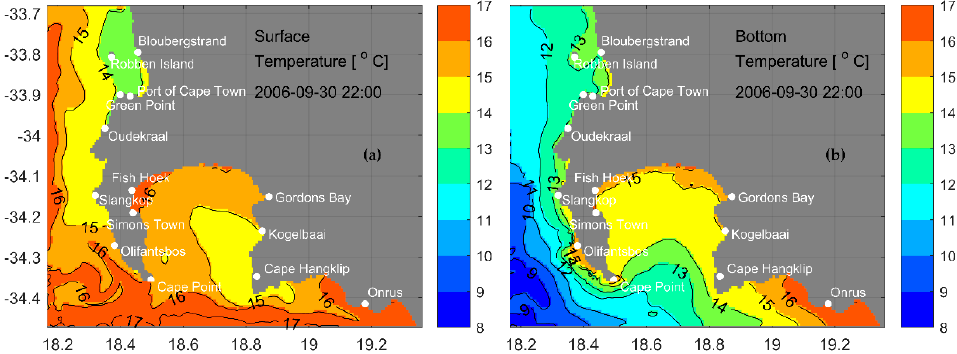
Figure 16. Surface ( a ) and bottom ( b ) temperature following moderate westerly and north-westerly winds.